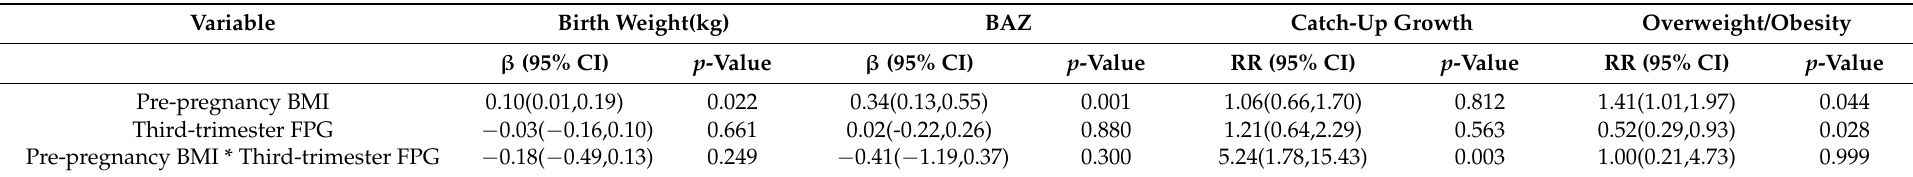
Table 2. Multivariate regression of offspring anthropometric outcomes from 1 to 24 months according to maternal pre-pregnancy BMI and third-trimester FPG ( β /RRs and 95% CI). ( n = 483).